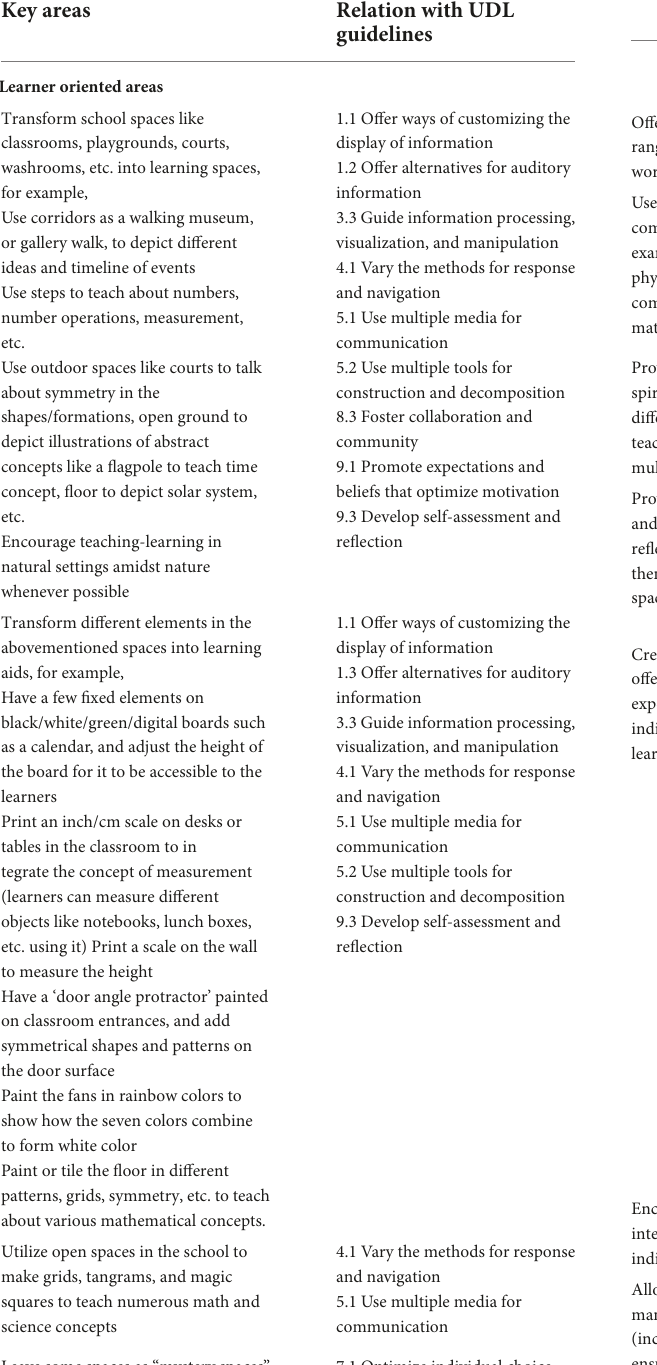
TABLE 2 Key areas to ensure educational equity and their alignment with UDL. Key